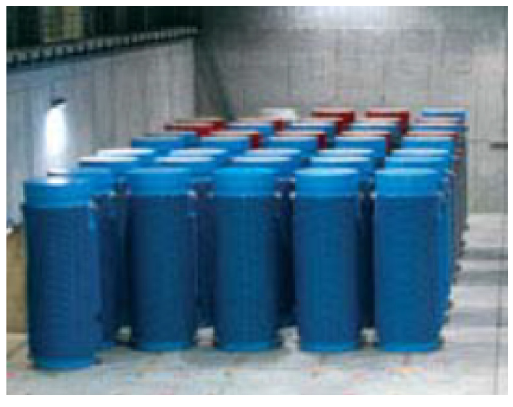
Fig. 3. Metal casks